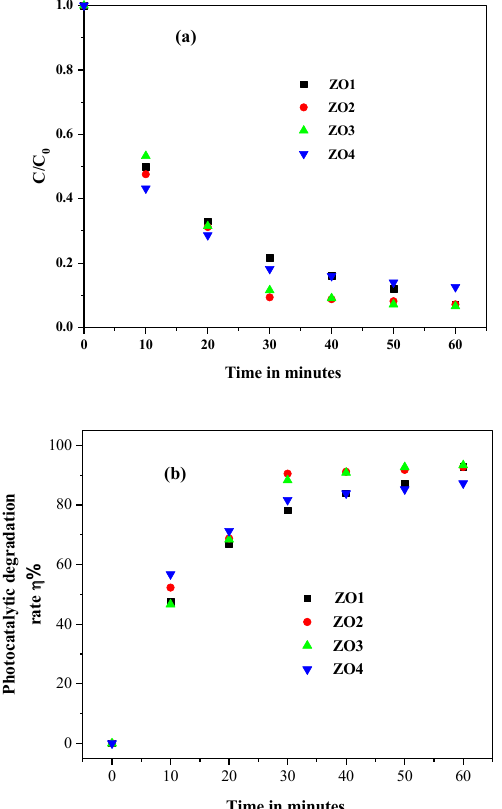
Fig. 6. (a) and (b) photo catalytic properties of ZO series compounds on EB dye by keeping the amount of catalyst (0.010 g/L), concen- tration of dye (0.40 mg/L) and time of irradiation